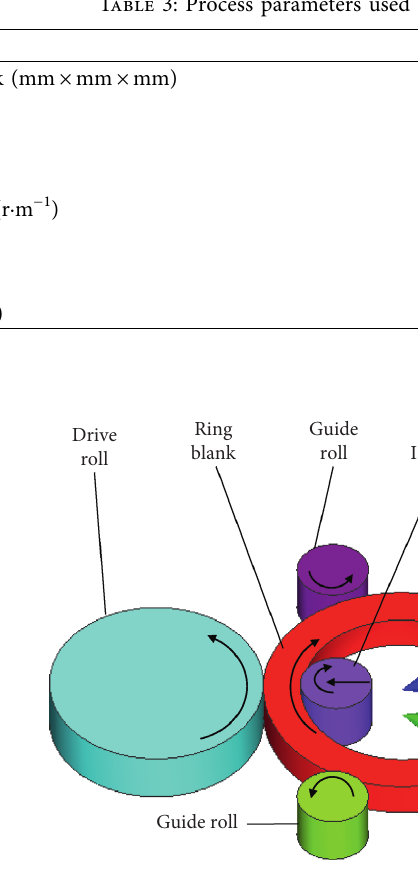
Figure 11: The finite element model of the hot ring rolling process.